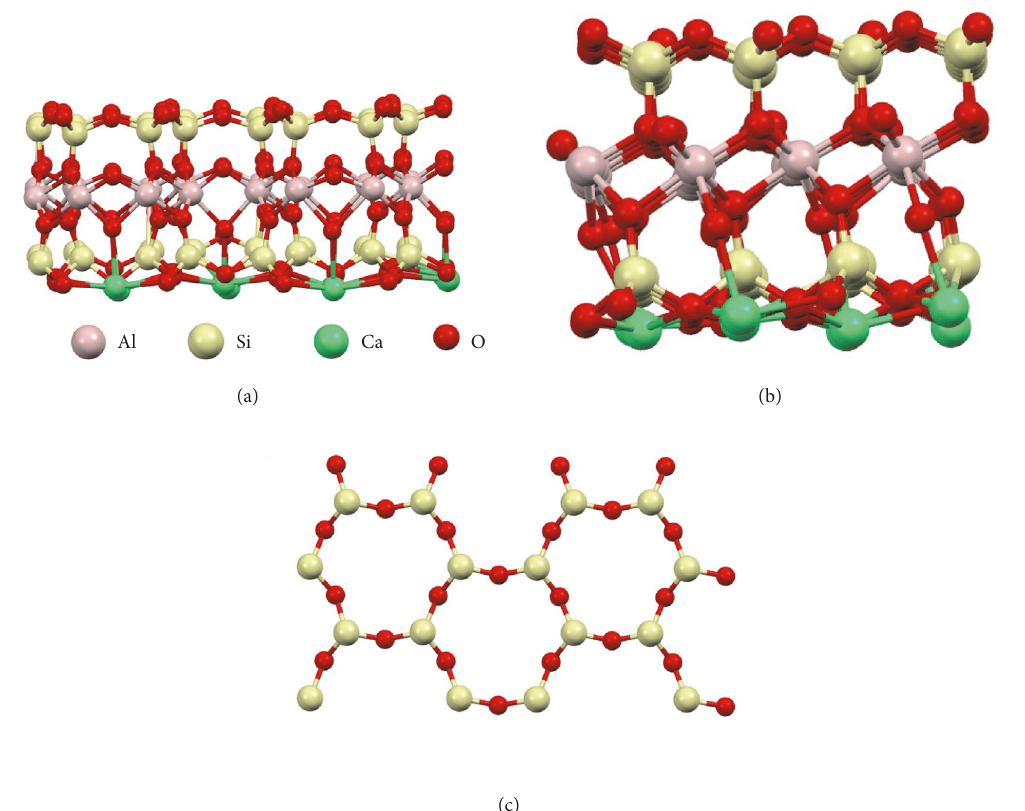
Figure 1: Super cell of montmorillonite. (a) front view, (b) side view, and (c) top